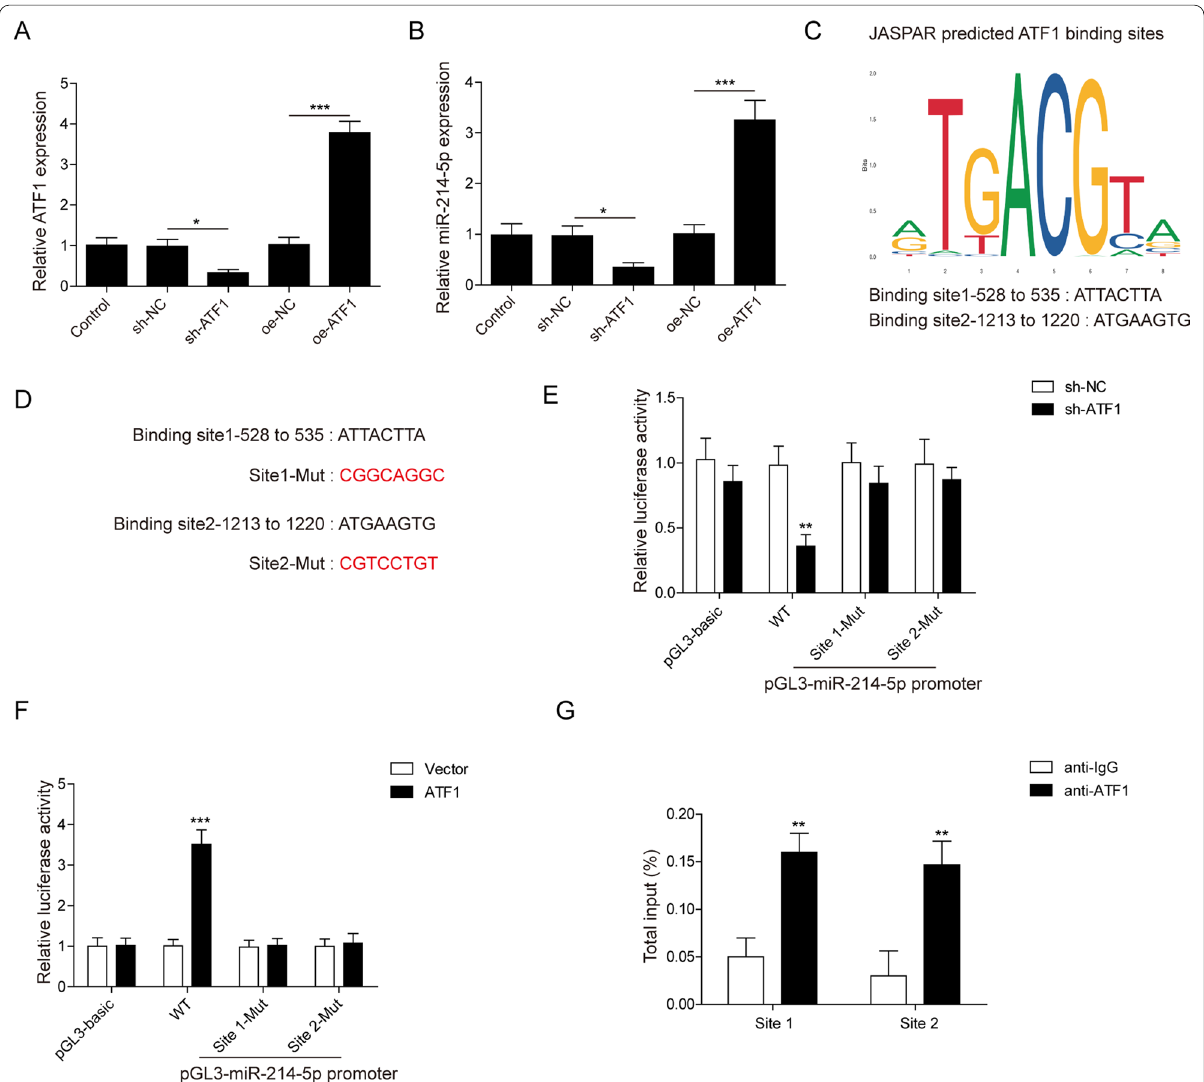
Fig. 2 MiR‑214‑5p is transcriptionally activated by ATF1. Knockdown or overexpression of ATF1 were performed in RAW264.7 cells, ATF1 ( A ) and miR‑214‑5p ( B ) expression in each group were detected via qRT‑PCR. C Two predicted binding sites by JASPAR. D ATF1 and miR‑214‑5p promoter binding site mutation sequence. E , F Luciferase reporter assay in cells transfected with a plasmid containing miR‑214‑5p‑WT, Site 1‑MUT and Site 2‑MUT. Sh‑ATF1 and ATF1 overexpression vector were administrated, respectively. G ChIP assays was conducted in RAW264.7 cells. qRT‑PCR was utilized to examine miR‑214‑5p promoter expression associated with ATF1. Experiments were performed for at least 3 times. Data are presented as mean SD. *P < 0.05, **P < 0.01 and ***P < ±